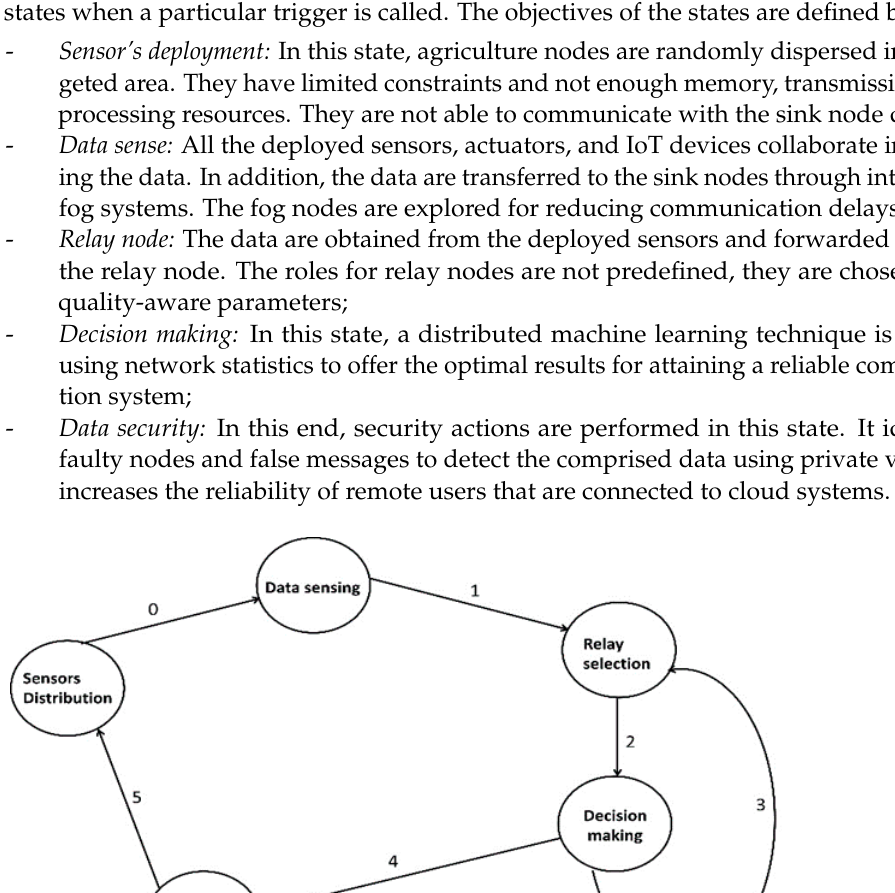
Figure 4. Flowchart of the proposed security algorithm.